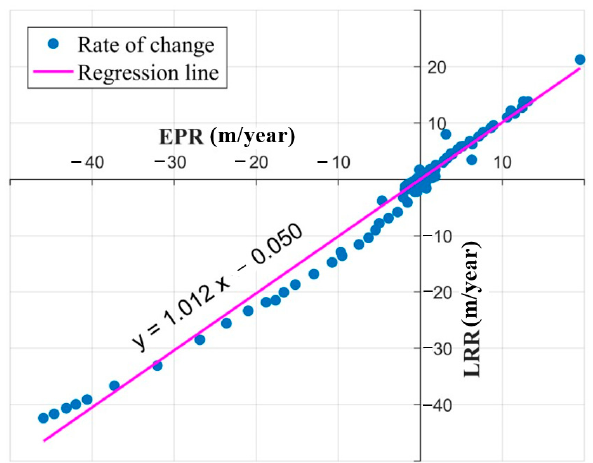
Figure 12. Comparison of rate of change obtained by the EPR and LRR for the Quang Nam coast.